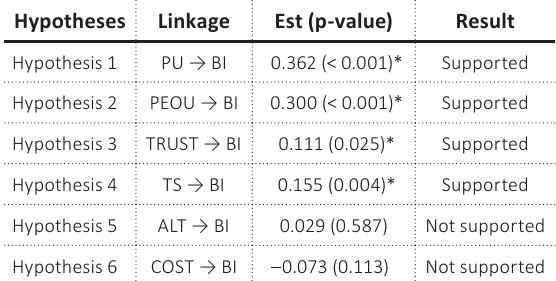
Table 3. Hypotheses testing